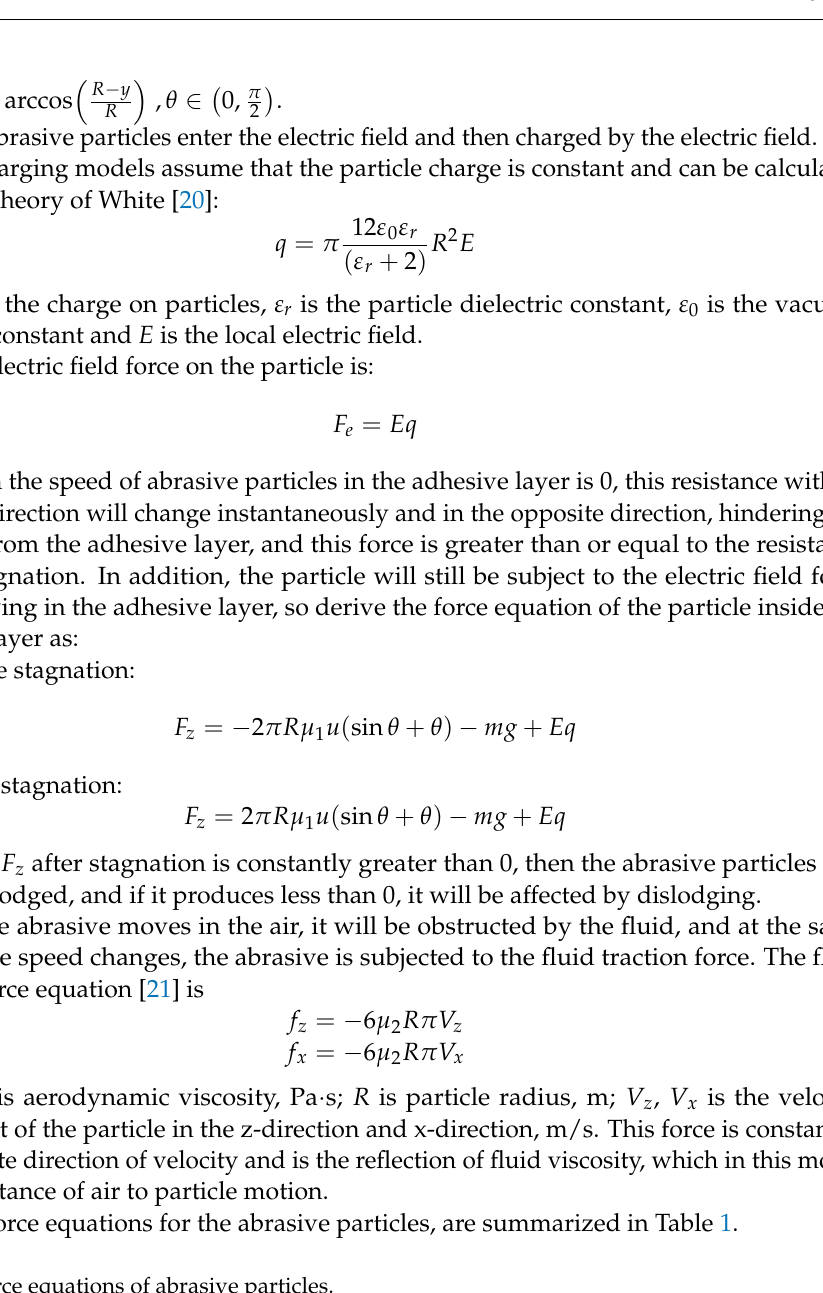
Table 1. Force equations of abrasive